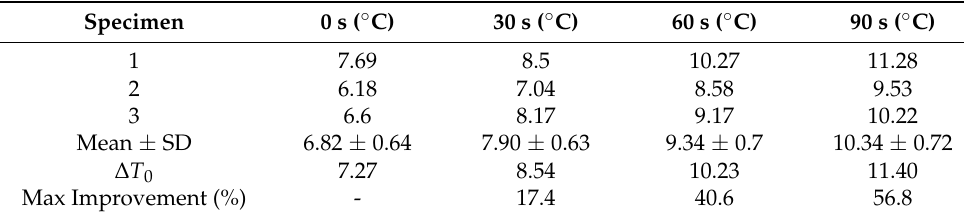
Table 2. Maximum cooling temperature of films prepared by ZnO NPs with plasma treatment for 0, 30, 60 and 90 s.